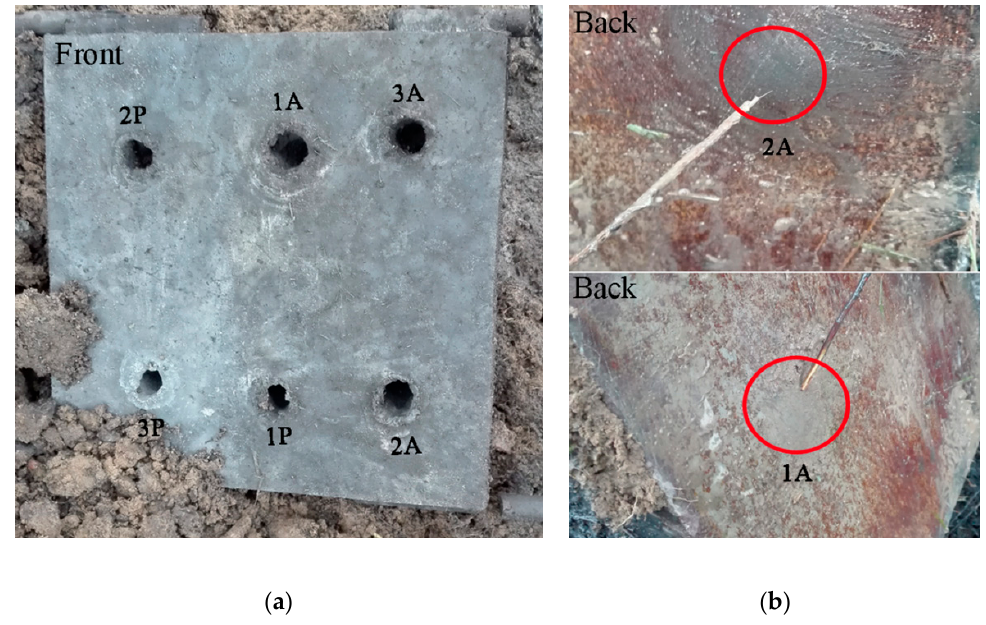
Figure 7. Plate class 1 after firing with ŁK charge: ( a ) holes after axial (1A, 2A and 3A) and peripheral Figure 6. Plate class 1 after firing with Ł K charge: ( a ) holes after axial (1A, 2A and 3A) and peripheral charges (1P, 2P and 3P); ( b ) no perforation for 1A and 2A shots. charges (1P, 2P and 3P); ( b ) no perforation for 1A and 2A shots.